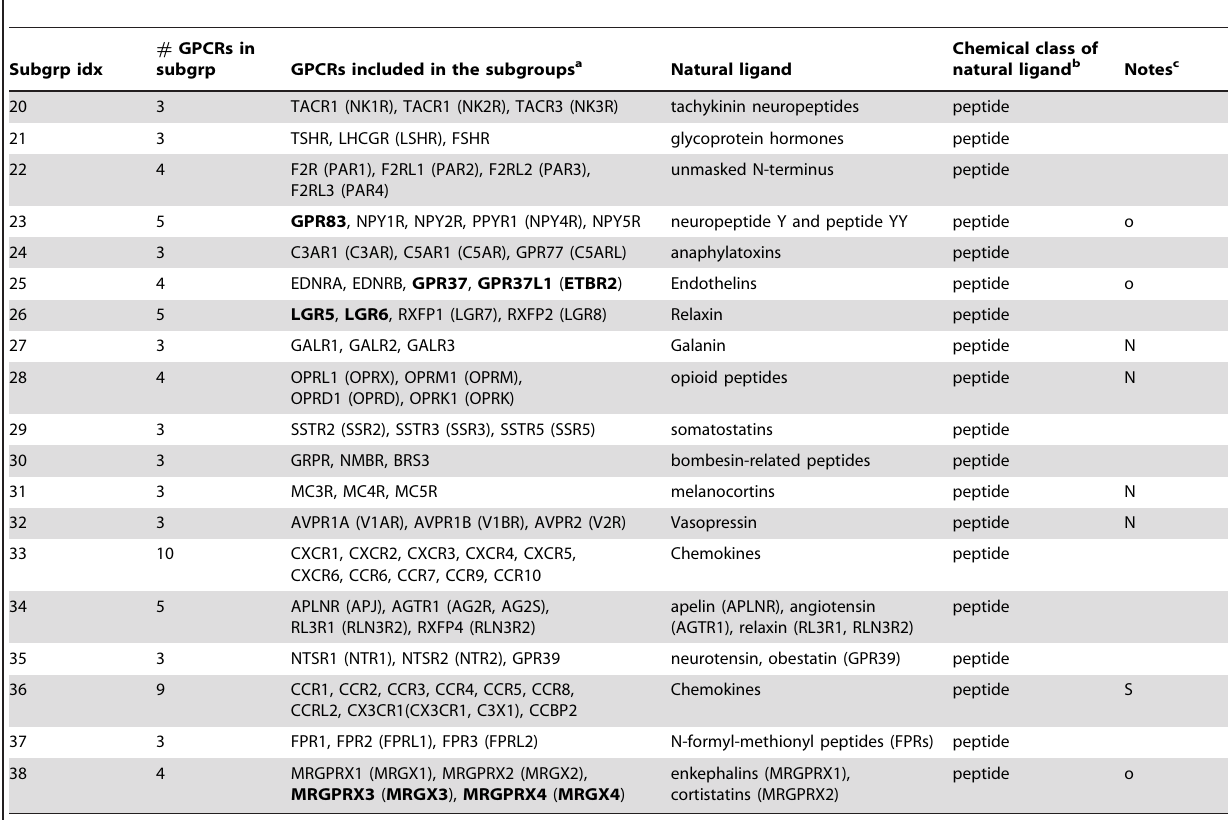
Table 3. List of class A GPCRs included in the study (continued from Tables 1, 2).